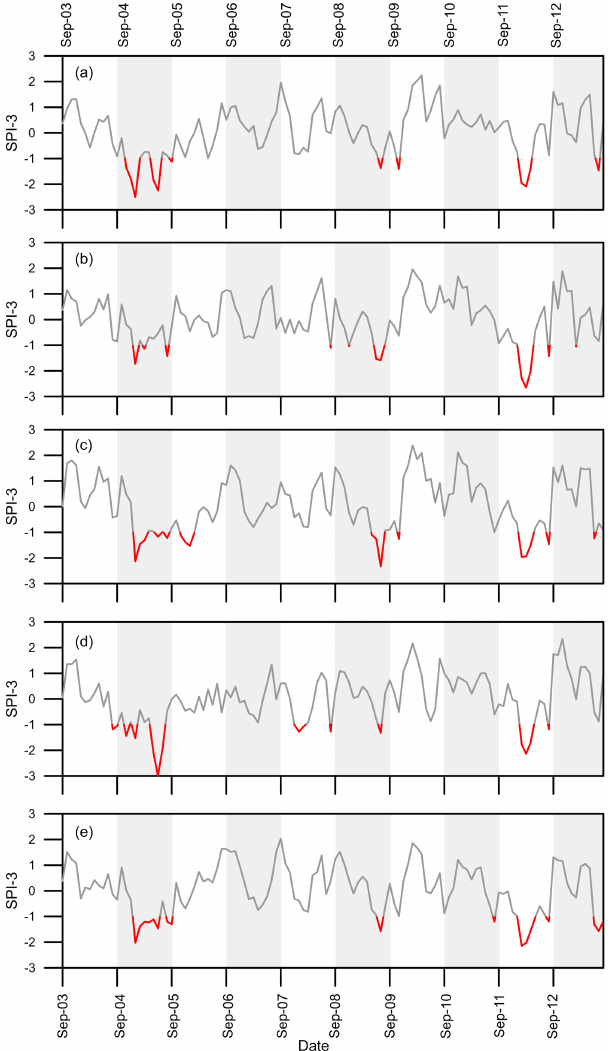
Figure 3. Variation of the soil moisture anomaly index (SMAI) dur- ing the period studied (2003–2013) in the five selected agricultural regions: (a) Campiña de Cádiz, (b) Campiña Baja, (c) Pedroches, (d) Norte/Antequera and (e) La Campiña. Red lines indicate values below the defined threshold of −